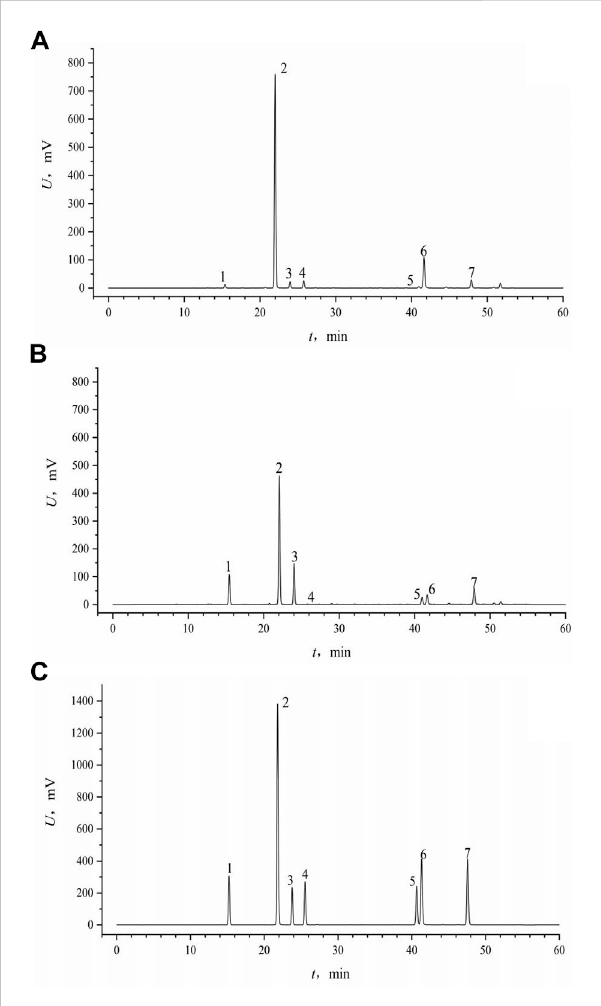
FIGURE 3 HPLC chromatograms of the raw sample (A) , processed sample (B) , and mixed standards (C) at 325 nm. 1.5-CQA; 2.3-CQA; 3.4-CQA; 4. CA; 5.3,4-DiCQA; 6.3,5-DiCQA;